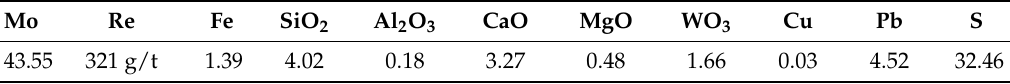
Table 1. Main chemical composition of lead-rich molybdenite concentrate/wt.